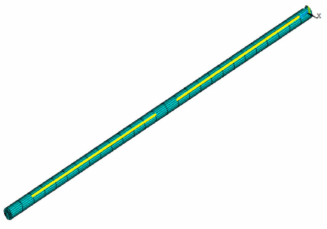
Figure 6. Trace of nut motion.